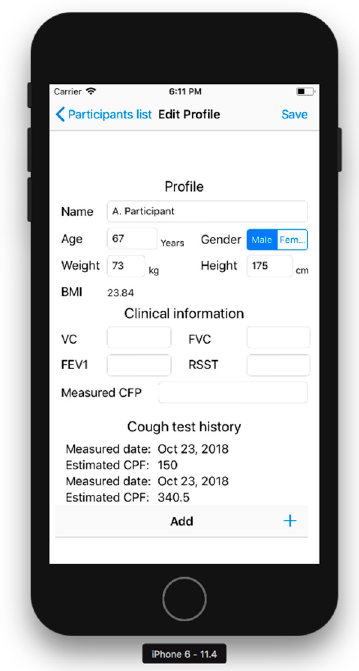
Figure 2. Editorial part. This screen prompts the user to complete their personal profile. BMI, body mass index, BMI = body weight/height 2 ; VC, vital capacity; FVC, forced vital capacity; FEV 1 , forced expiratory volume in 1 s; RSST, repetitive saliva swallowing test.